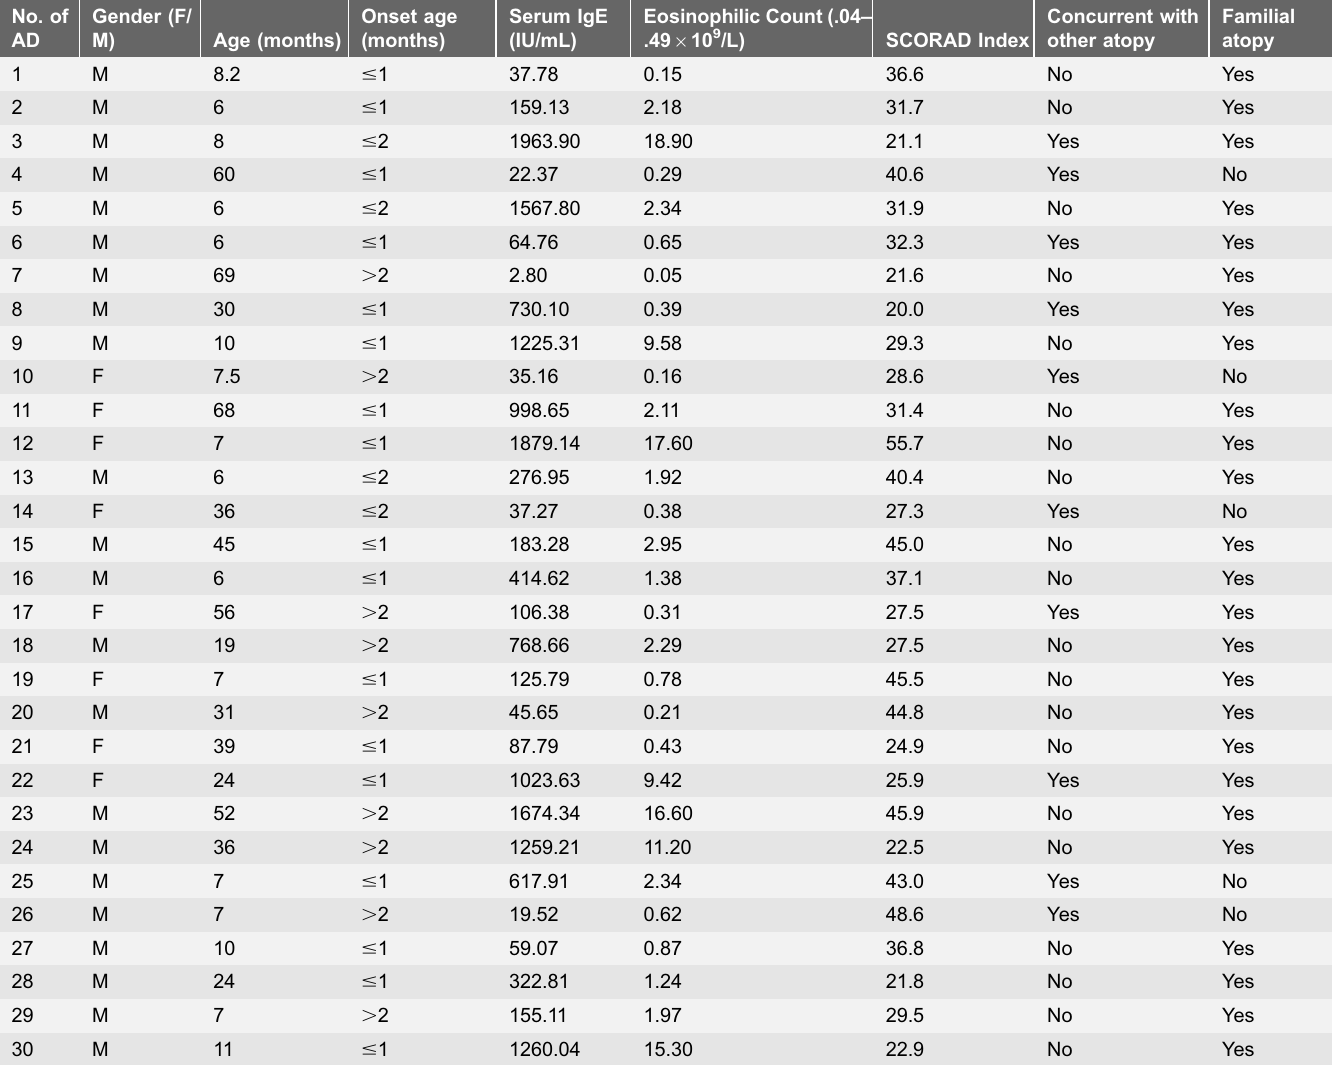
Table 1. Demographics of childhood